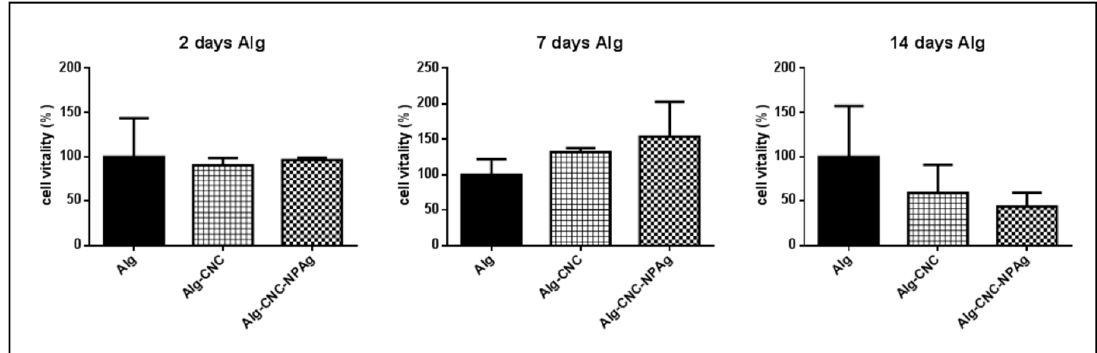
Figure 5. Cell viability % of HepG2 cells on ALG (5% w/v ), ALG/CNC (5% and 3% w/v ) and ALG/CNC (5% and 3% w/v ) + AgNP (100 ppm) scaffolds.